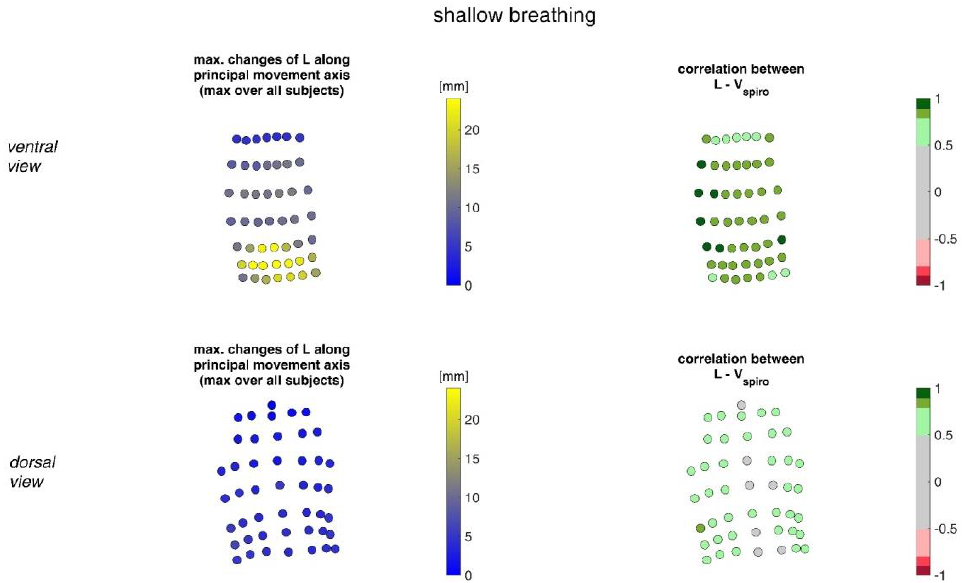
Figure 9. The maximal changes of the movements of MoCap markers along their principal movement axis during shallow breathing (mean over all subjects (left)) and the mean corresponding correlation of these changes with spirometer volume V spiro of all subjects during shallow breathing are shown (right). (Top - ventral view, bottom - dorsal view).